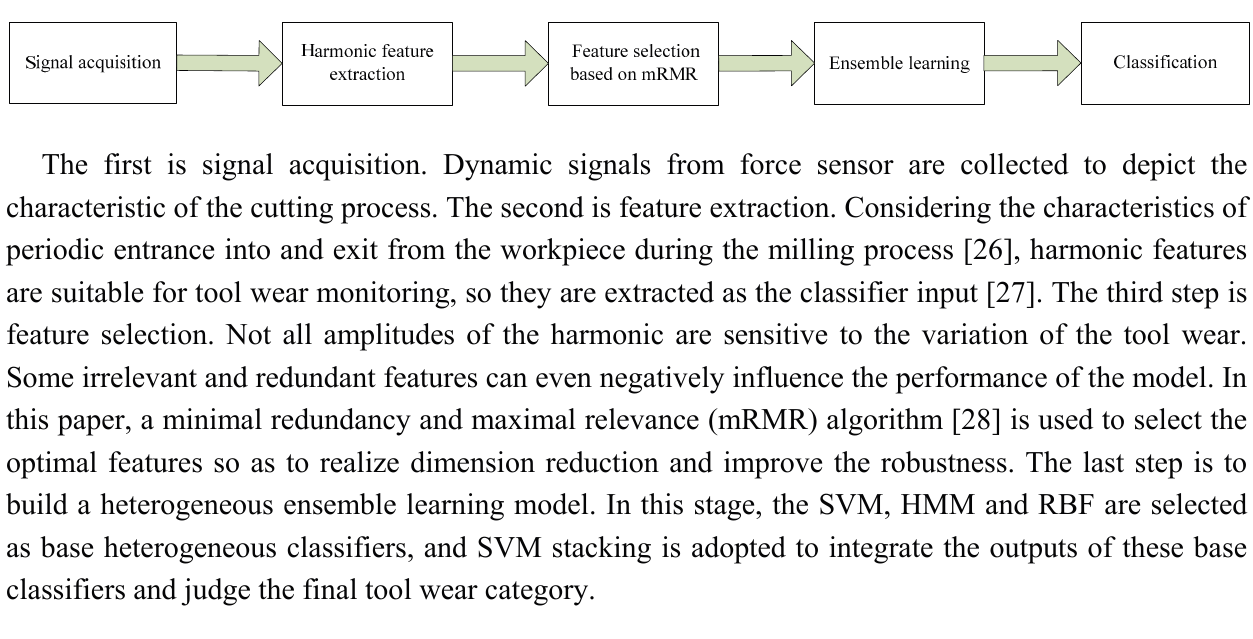
Figure 3. Framework of the tool condition monitoring